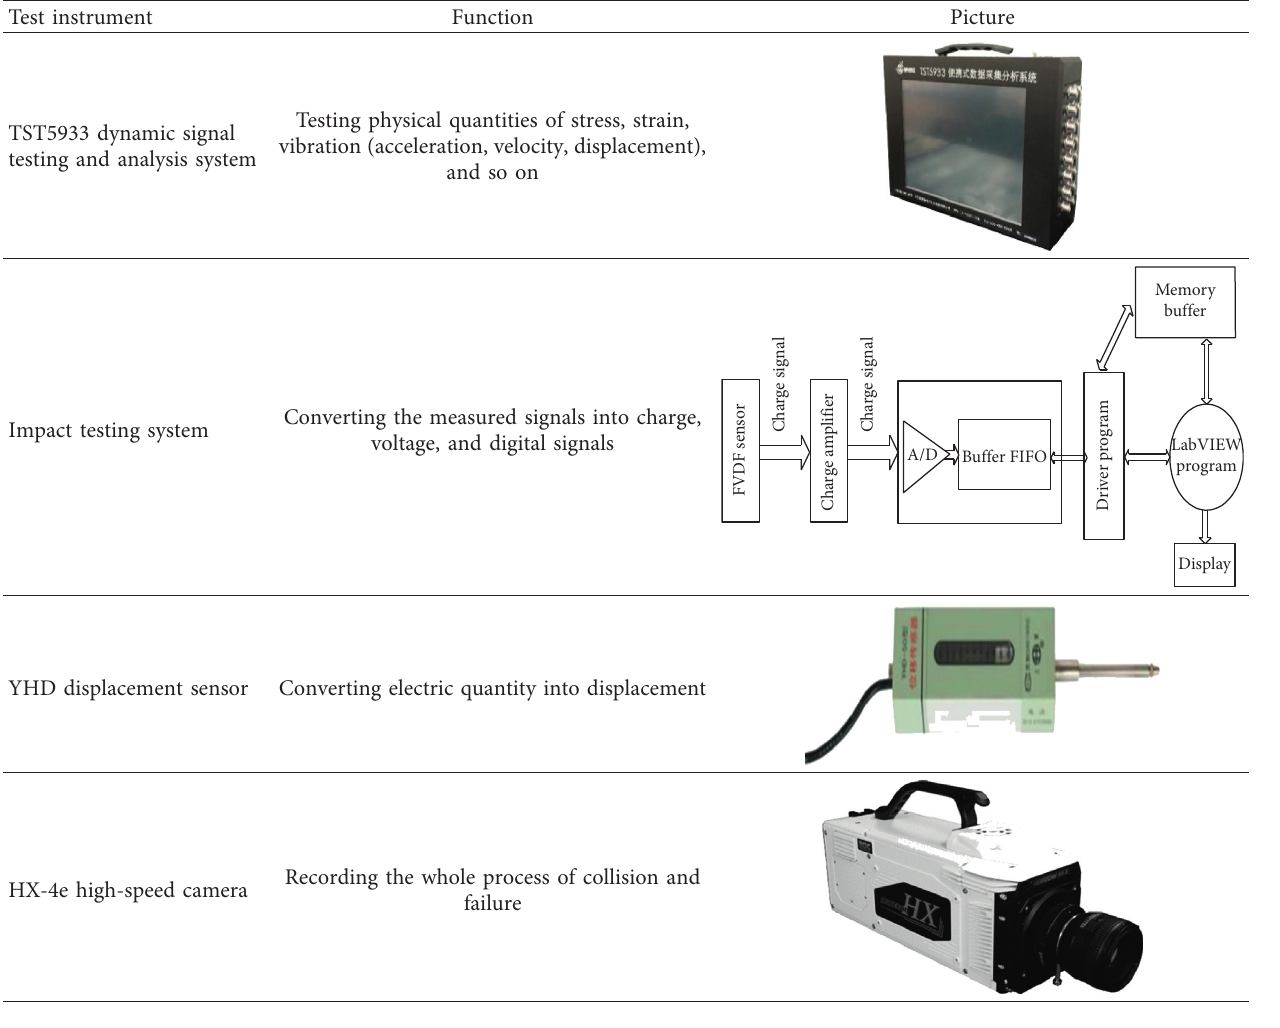
Falling Heights. Figure 20 reflects the variation of dis- placement of column top under different impact heights.